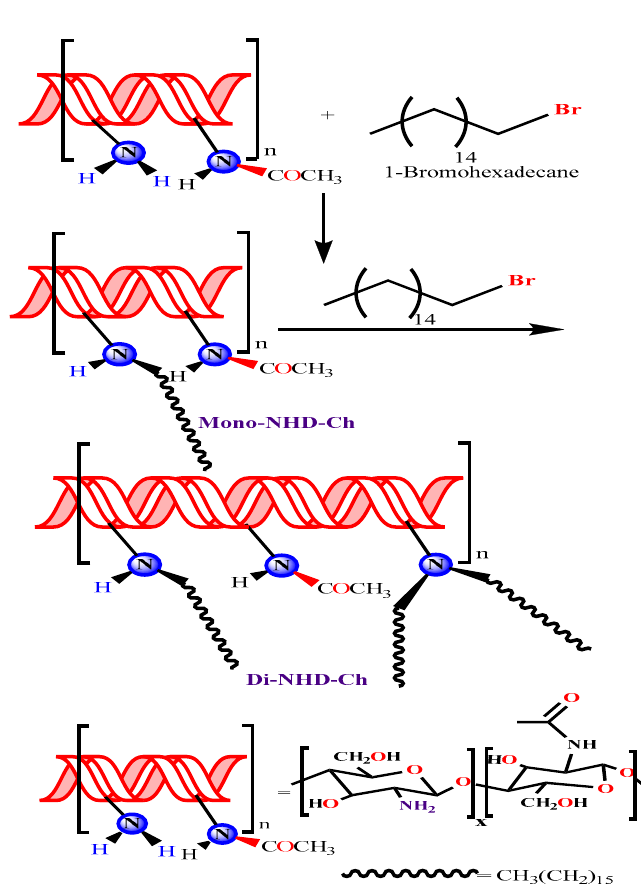
Figure 1. Schematic preparation of mono and di N hexadecanyl chitosan.